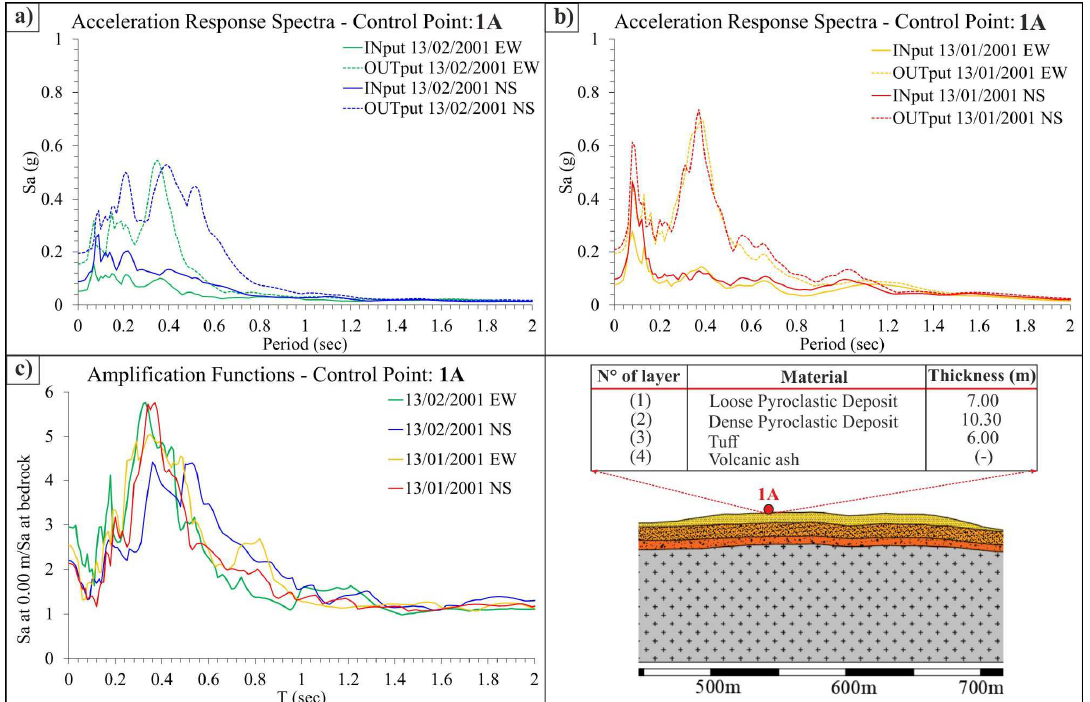
Figure 13. Section AA†: numerical control point 1A spectral responses obtained by 2D numerical analyses using LSR2D software. ( a ) Comparison among the SA of the two components of the 13 February 2001 earthquake. ( b ) Comparison among SA of the two components of the 13 January 2001 earthquake. ( c ) Amplification functions related to the four input motions.